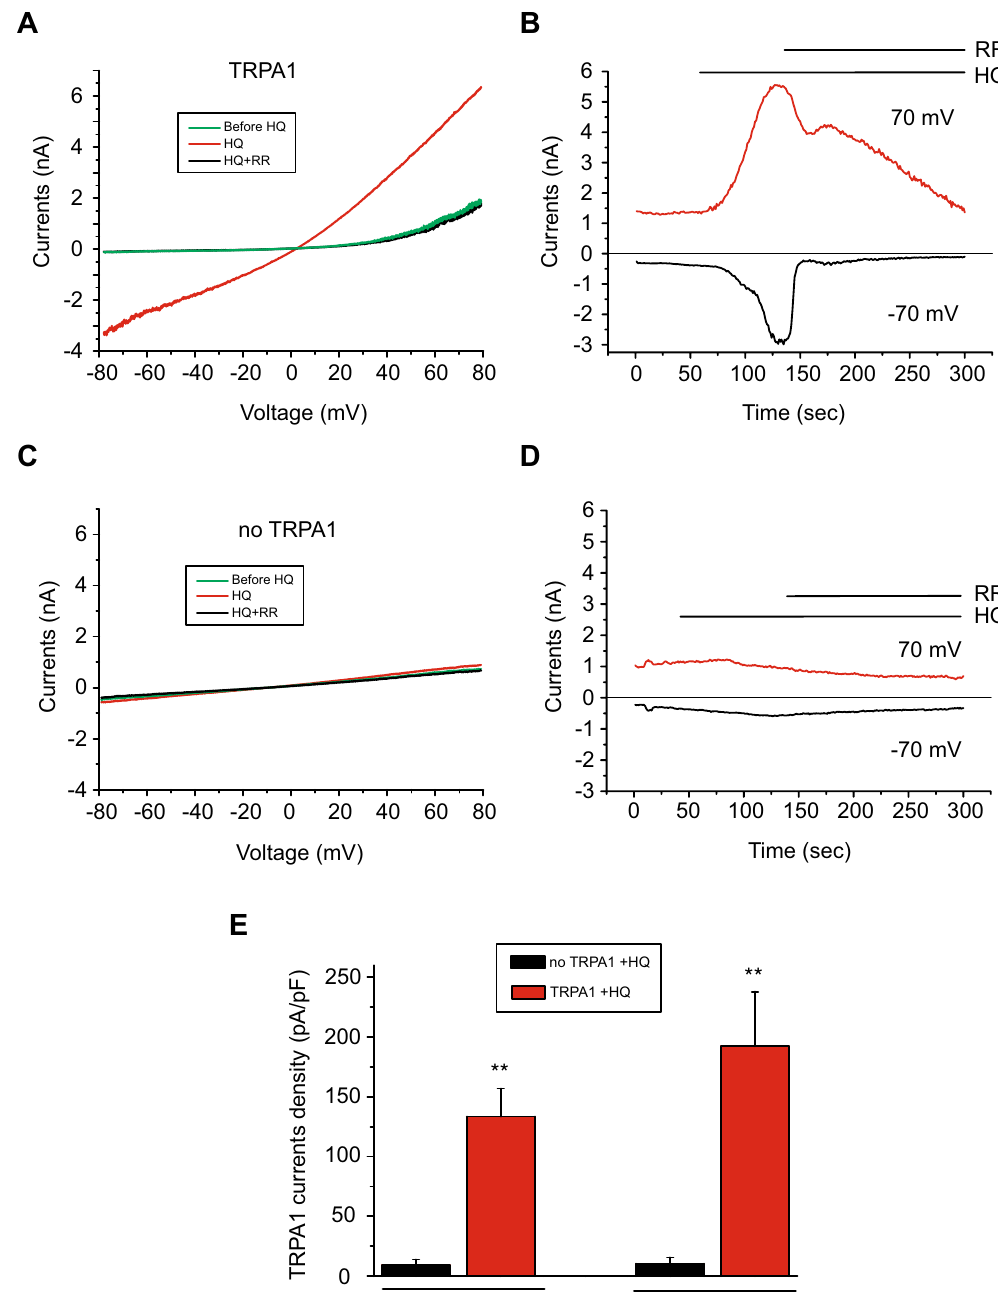
Figure 2. HQ evokes TRPA1 channel currents in HEK 293 cells expressing TRPA1. ( A ) Current-voltage (I-V) curve recorded from a representative HEK 293 cell expressing human TRPA1 before HQ application (green), during HQ application (red) and inhibition by ruthenium red (10 µ M, black) in the patch clamp whole-cell configuration. Currents were measured by applying a voltage ramp ranging from − 80 to + 80 mV. ( B ) Time courses of the inward (measured at − 70 mV, black) and outward current (measured at + 70 mV, red) recorded in ( A ). ( C ) I-V curve recorded under the same configuration as in ( A ), except that the cell was transfected with empty vector. ( D ) The time course of the inward (measured at − 70 mV) and outward current (measured at + 70 mV) as recorded in ( C ). ( E ) Summary of the inward and outward current density recorded at − 70 and + 70 mV, respectively, in HEK 293 cells expressing hTRPA1 or empty vector. ** p < 0.01 vs . vector TRPA1 expressed in mouse primary sensory neurons is a molecular target of HQ. We proceeded to explore whether HQ stimulated primary sensory neurons through activation of TRPA1 in vitro . Cultured mouse dorsal root ganglion (DRG) neurons were loaded with Fura-2 for ratiometric Ca 2 + imaging. We observed